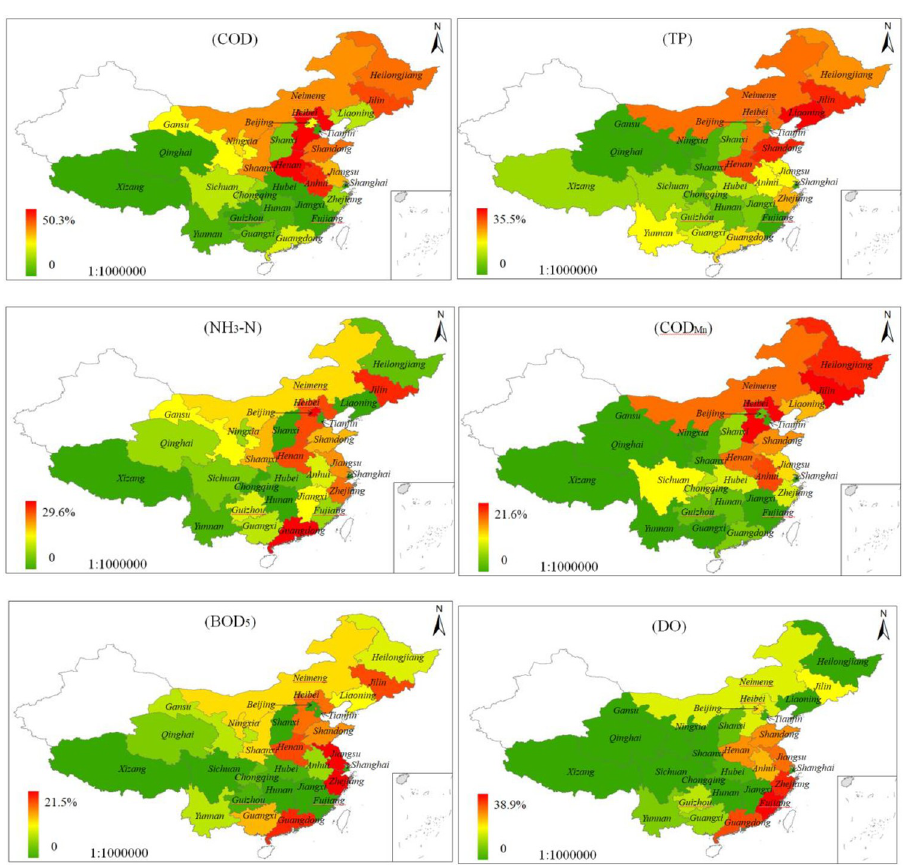
Fig 6. Spatial distribution of main elements exceeding standard limits (COD-Chemical oxygen demand; TP-Total phosphorus; NH 3 -N-Ammonia nitrogen; COD Mn -Permanganate index; BOD 5 -Biochemical oxygen demand; DO-Dissolved oxygen)